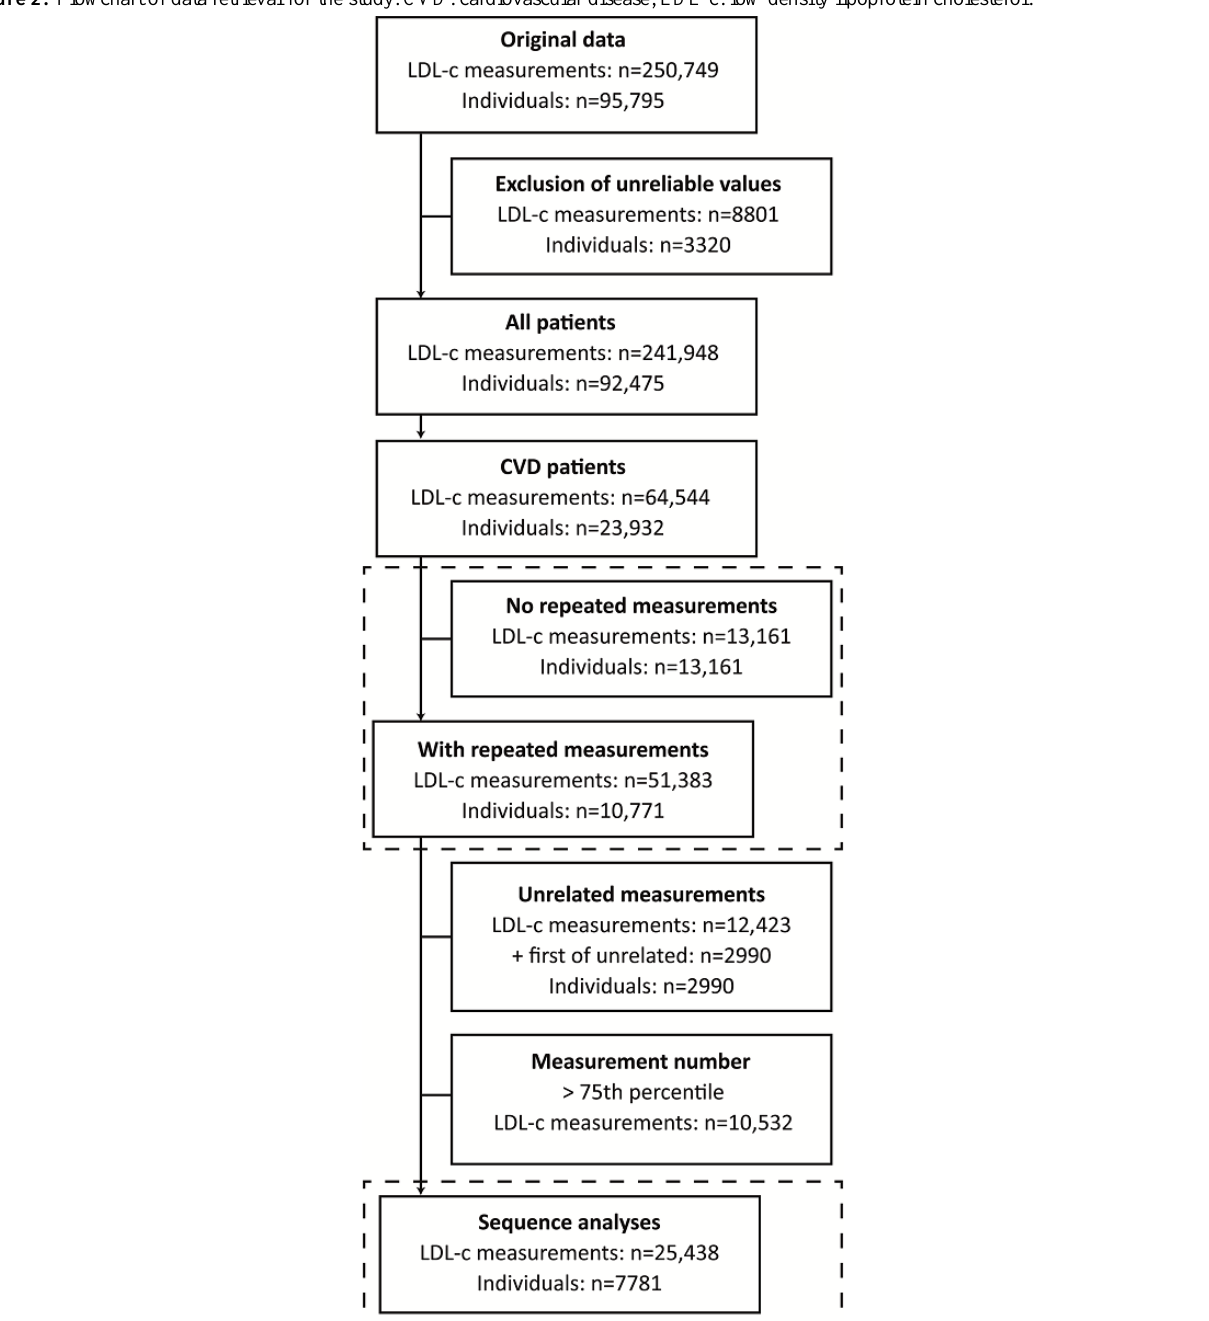
Figure 2. Flowchart of data retrieval for the study. CVD: cardiovascular disease; LDL-c: low-density lipoprotein